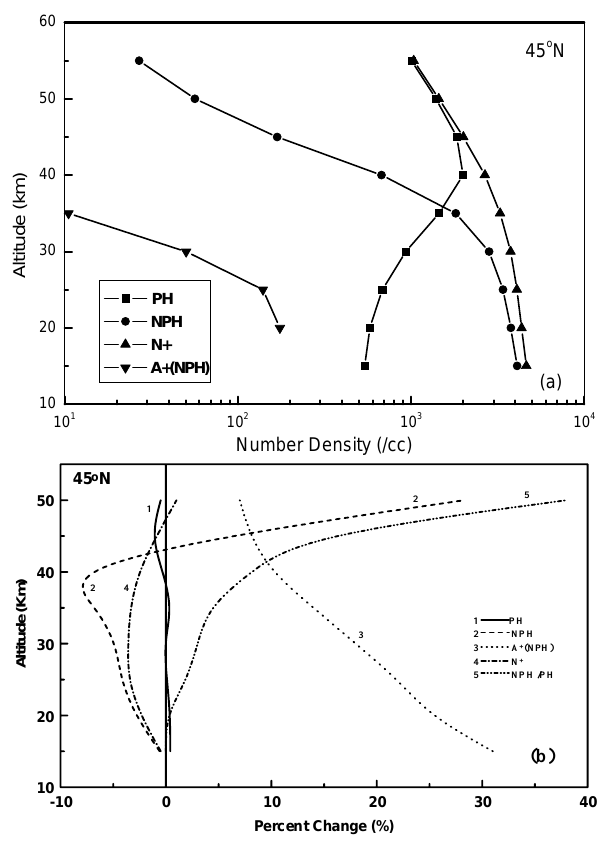
17 Fig. 3. (a) The number density (/cc) of major positive ions in the